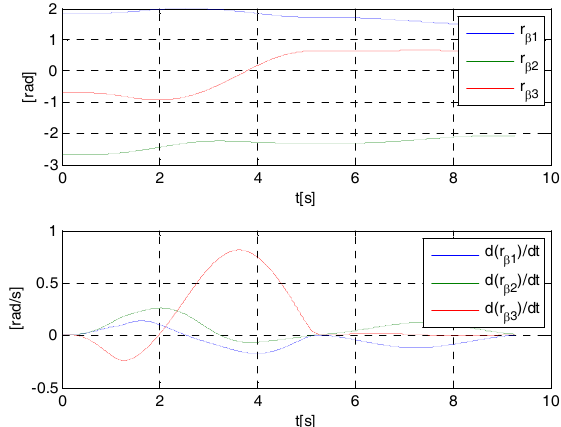
Figure 17. Time histories of ( ) r t